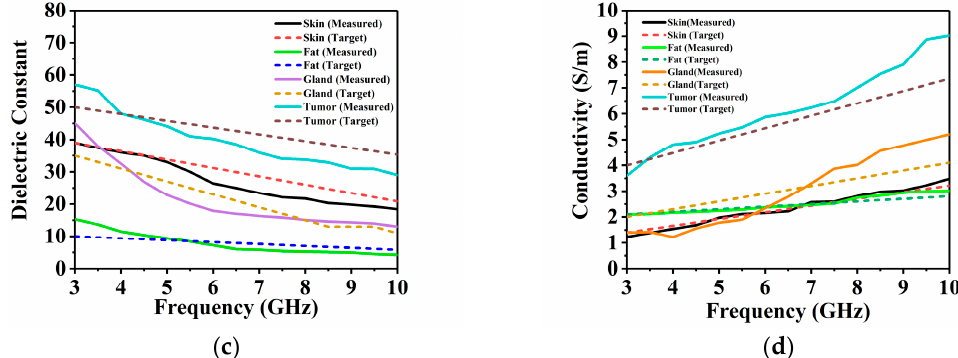
Figure 13. Dielectric constant and electrical conductivity of each material of homogenous ( a , b ), and heterogenous phantom ( c , d ).